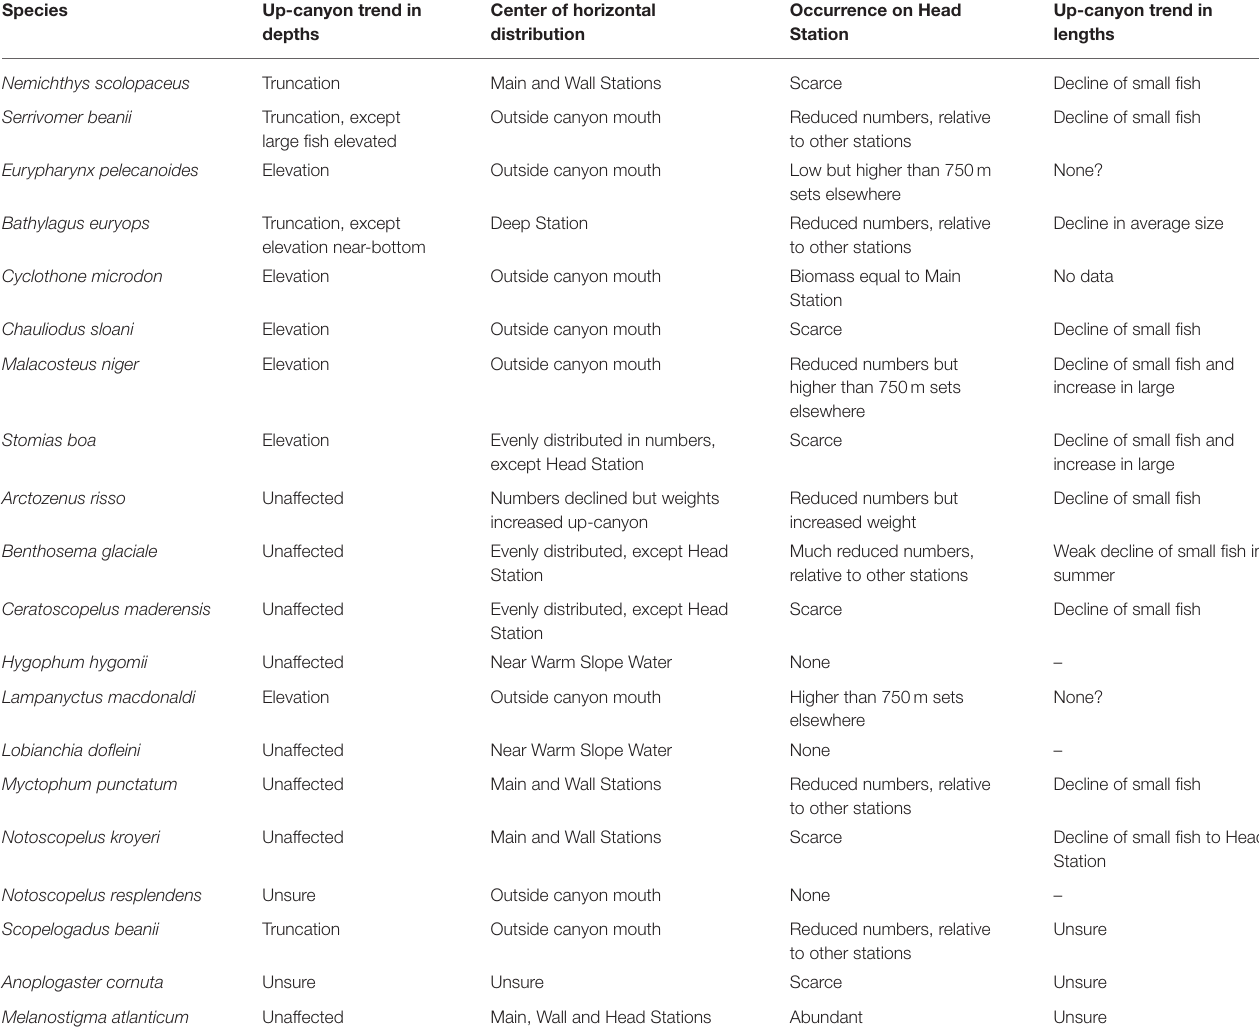
TABLE 8 | Up-Canyon trends in the distributions and sizes of the 19 analysed species (after Kenchington et al., 2018) and for Cyclothone microdon (after Thompson and Kenchington, 2017).